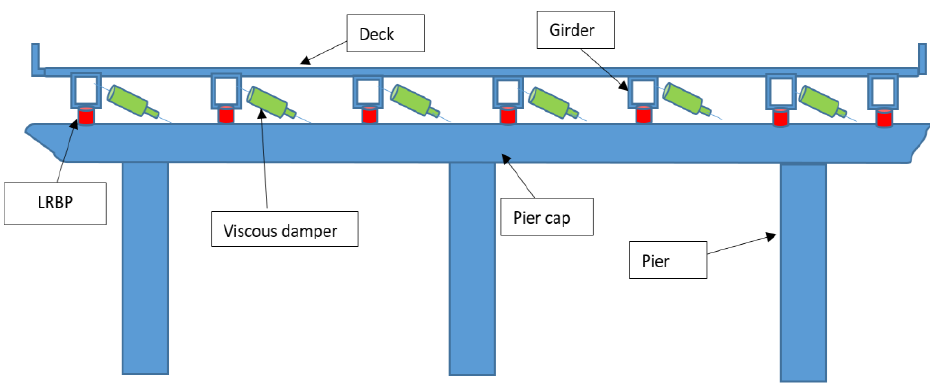
Figure 2. Schematic of the proposed system.